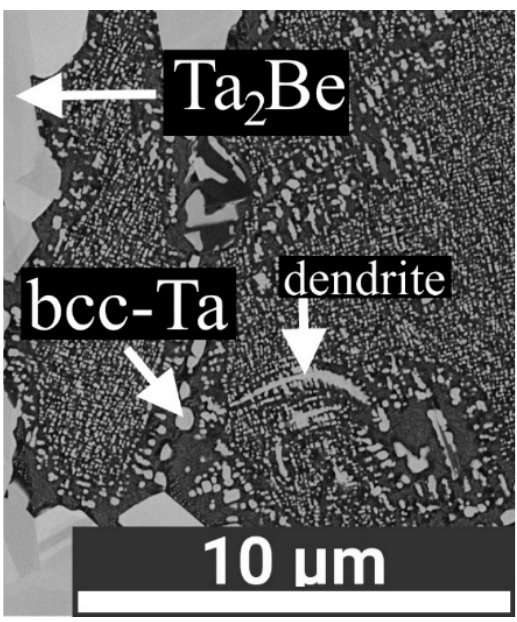
Figure 9. Magnified image of the zone outlined by the rectangle in Figure 8a in the Ta/TiZr4Be/W seam.